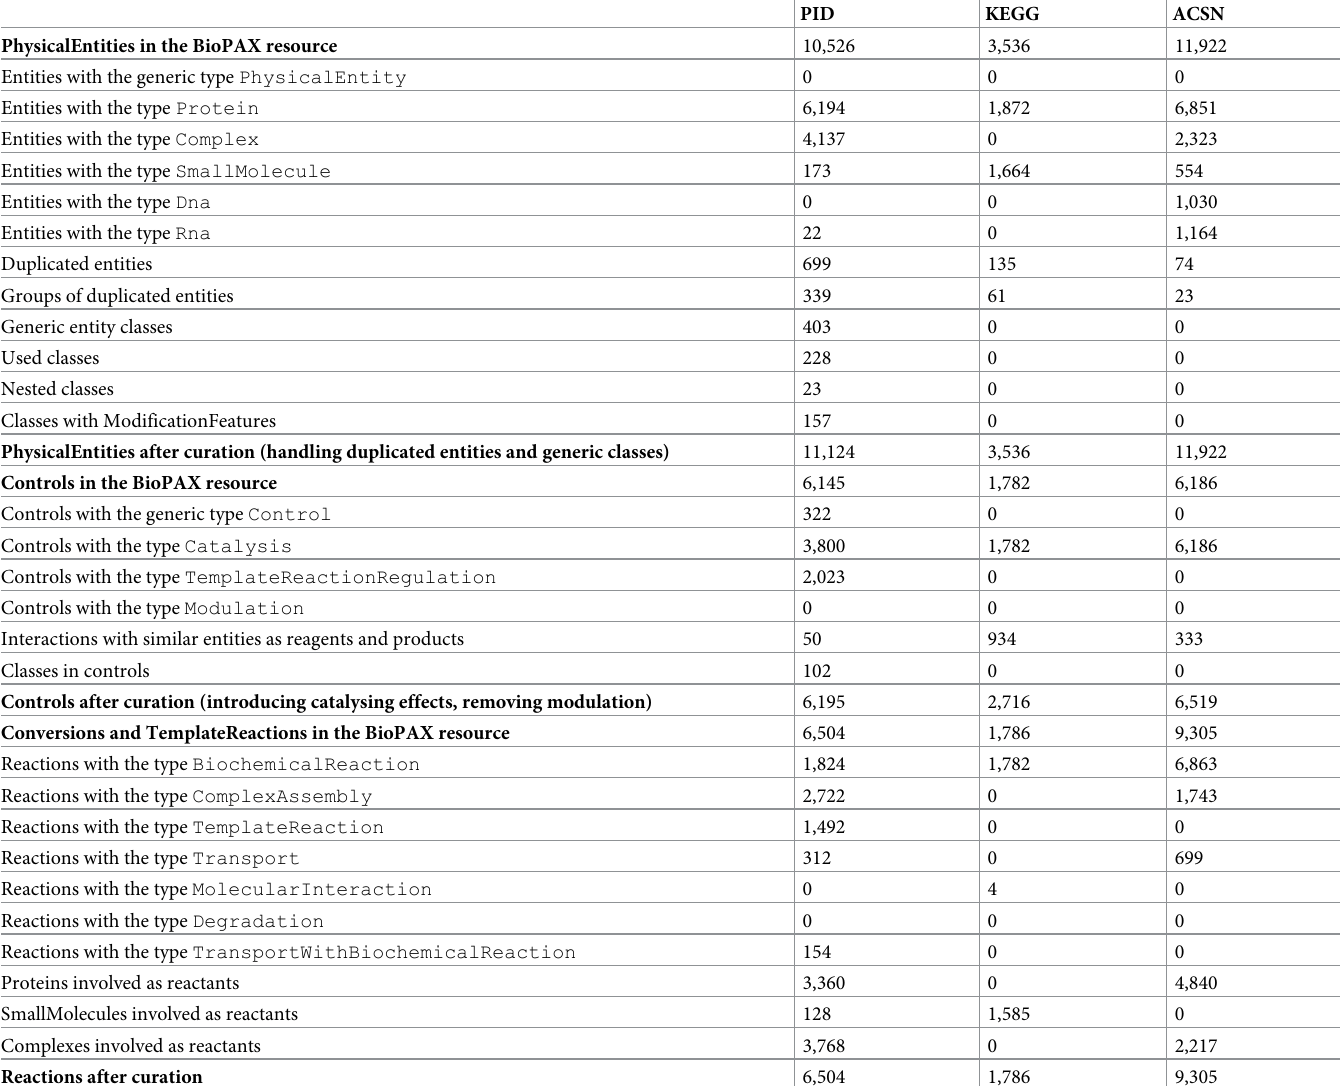
Table 1. Makeup of the BioPAX models from three resources (PID, KEGG, ACSN). The BioPAX files of the three resources were parsed in order to identify Physical Entities, Controls ( Catalysis and TemplateReactionRegulation ) and Reactions ( Conversion and TemplateReaction ). For the ACSN resources, Physical Entities were curated in order to reanotate their types when possible. The curation processes focused on compressing duplicate entities and creating controls (with the type catalysis) for reactions where a reactant is also a